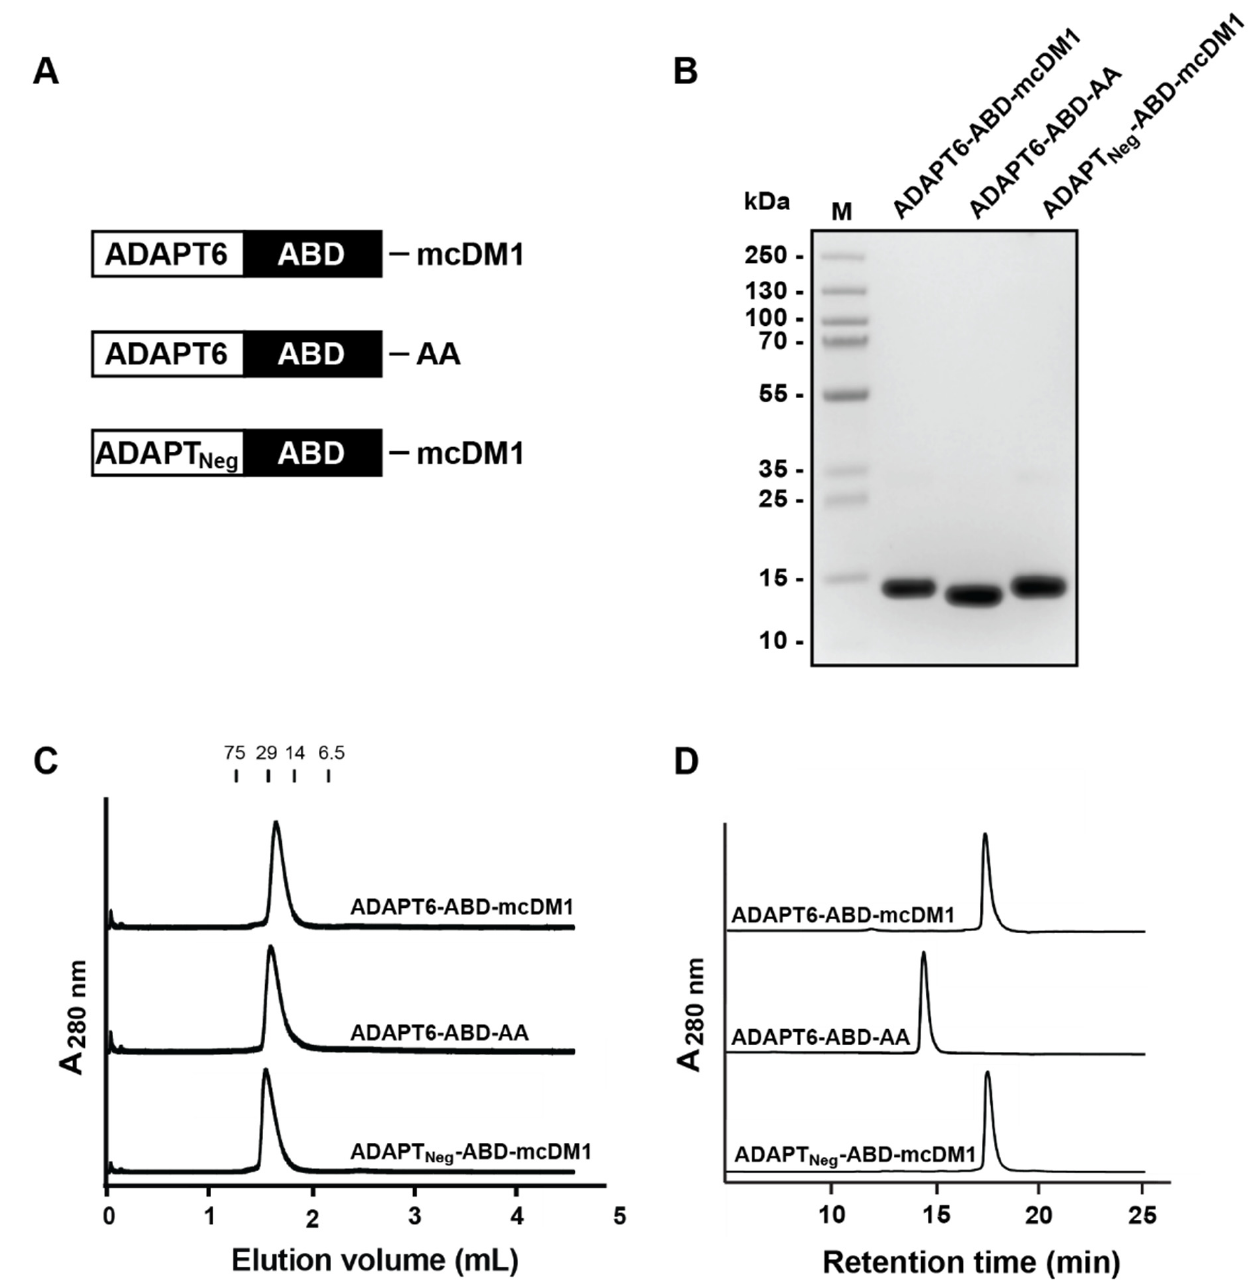
Figure 1. Biochemical characterization. ( A ) Schematic description of the ADAPT drug conjugates (ADAPT-DCs) and the non-toxic control ADAPT6-ABD-AA. A (Ser 3 Gly) 3 -linker was used to connect the ADAPT and ABD domains in all constructs. ( B ) SDS-PAGE analysis under reducing conditions. 5 µ g material was loaded in each lane. The molecular weights of marker proteins in lane M are shown on the left side. ( C ) Size-exclusion chromatography analysis. Indicated above the chromatograms are elution volumes of marker proteins. The molecular weights (in kDa) of the marker proteins are also indicated above the chromatograms. ( D ) RP-HPLC analysis using a linear gradient (30–60%) of acetonitrile in water with 0.1% TFA during 20 min.